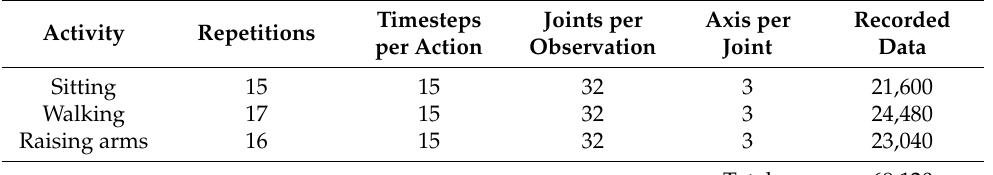
Table 5. Total data for testing the RNN.